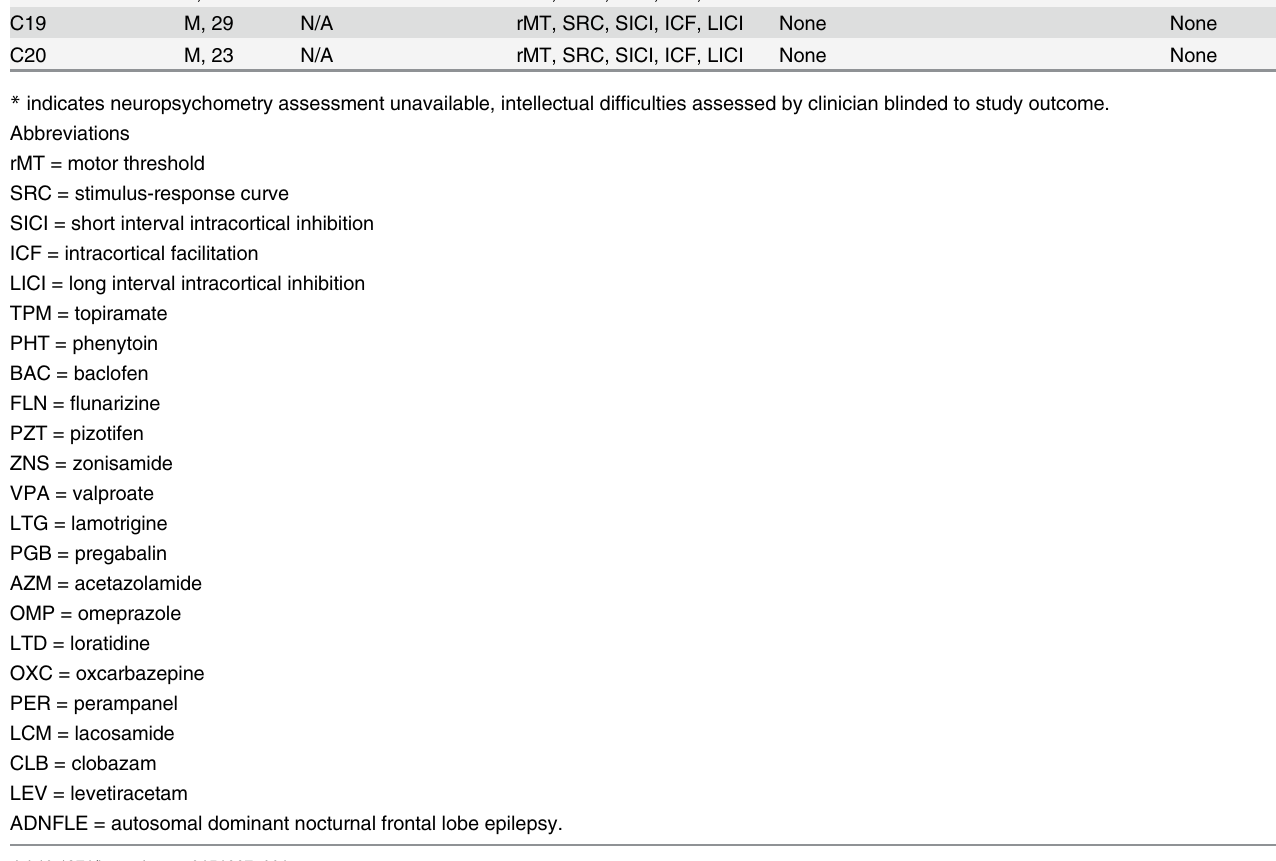
Table 1 shows their demographic information, genetic diagnosis (for those with AHC), epi- lepsy diagnosis (for epilepsy controls), medication at time of testing and degree of intellectual difficulties. There were no significant differences in age or proportions of males to females between the AHC group and either control group (age: unpaired, two-tailed t-test, P = 0.09 (AHC vs epilepsy controls), P = 0.07 (AHC vs healthy controls); sex: Fisher ’ s exact test P = 0.65 (AHC vs epilepsy controls), P = 0.37 (AHC vs healthy controls). Intellectual difficulties are common in AHC, and this is reflected in our population. Those with AHC were taking a mean of 2.1 medications each, while epilepsy controls were taking a mean of 2.5 medications each (see Table 1); there was no significant difference (unpaired, two-tailed t-test, P = 0.53). TMS during hemiplegic attacks A1 was tested during a prolonged hemiplegic attack. Onset of left sided weakness occurred five days prior to testing, with partial resolution by the day of testing; mild ongoing weakness